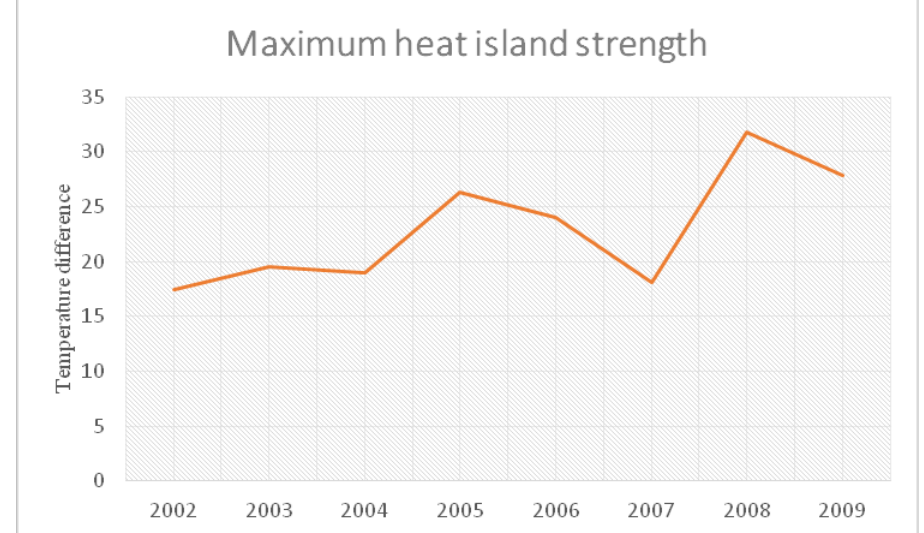
Fig. 3 Trend Chart of July Maximum Heat Island Intensity in Wuhan City